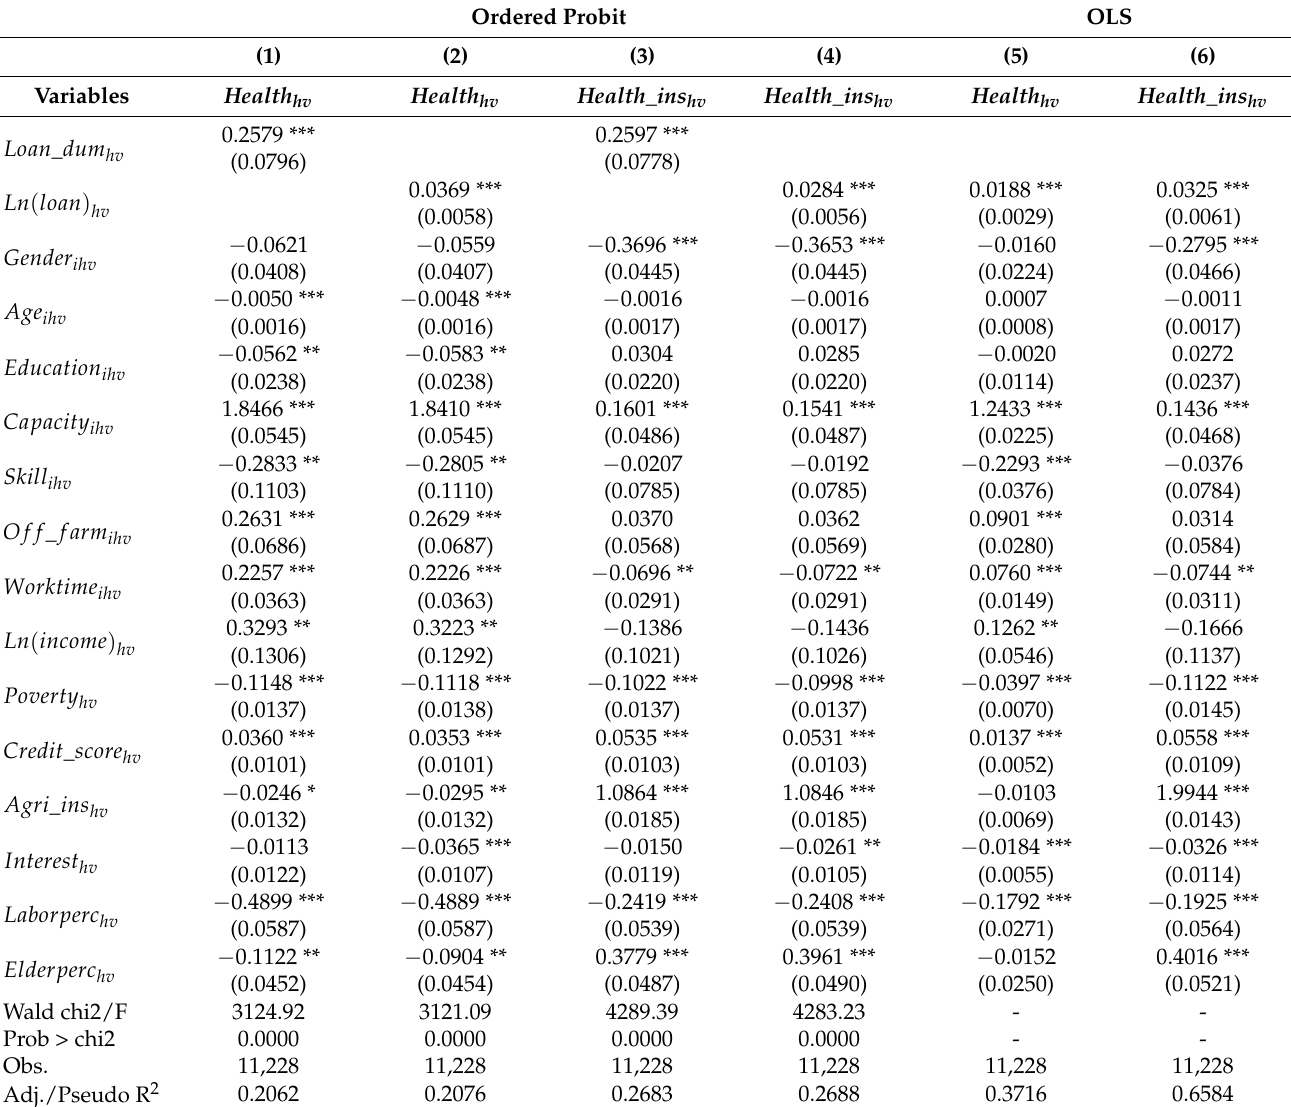
Table 2. The effect of microcredit on rural residents’